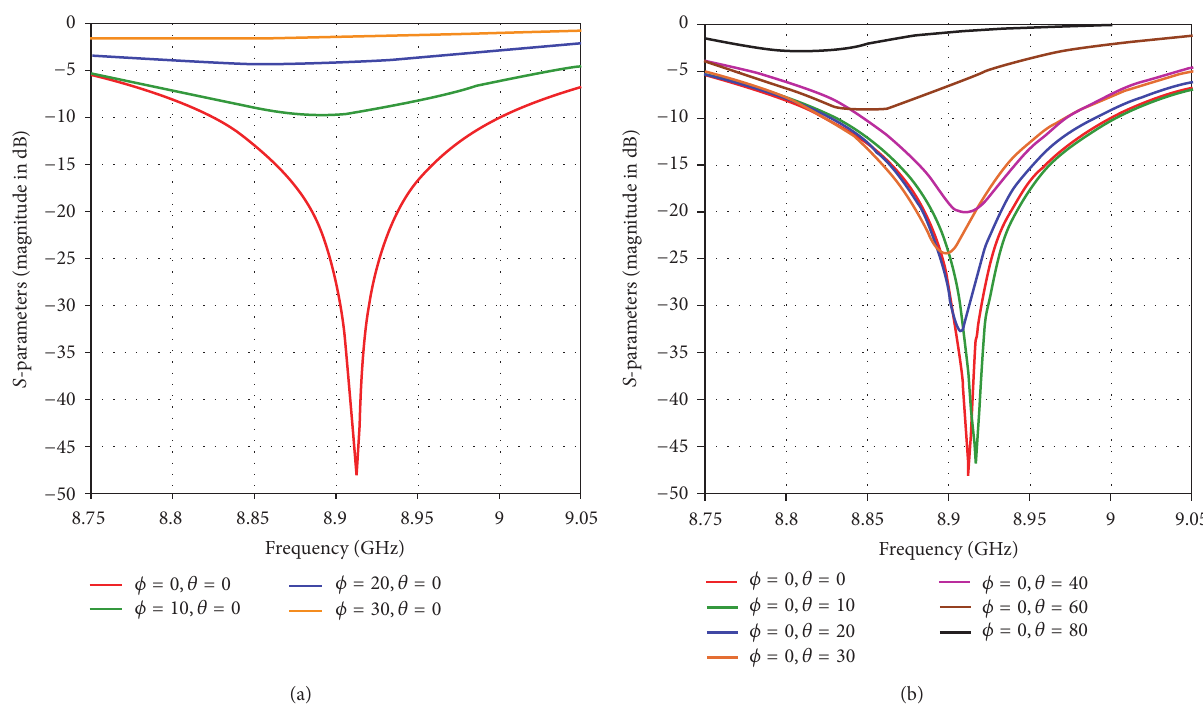
Figure 9: Frequency response of 𝑆 11 for different polarization angles: (a) 𝜃 = 0 ∘ and 𝜙 varies and (b) 𝜃 varies and 𝜙 = 0 ∘